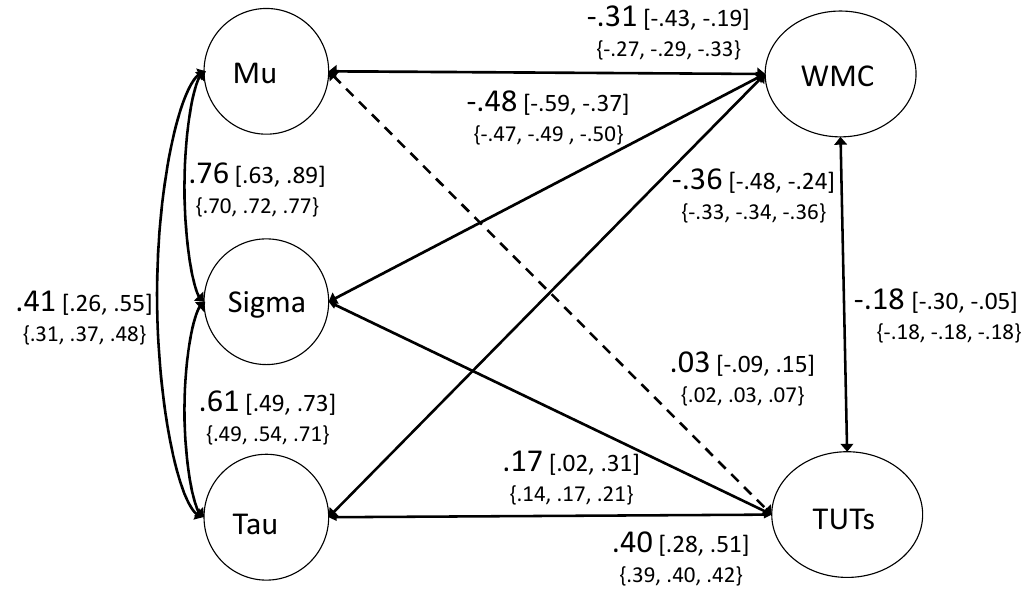
Figure 2. Confirmatory factor analysis of ex-Gaussian model. WMC = working memory capacity. TUTs = task-unrelated thoughts. Path estimates are presented in largest size font. The 95% confidence intervals are presented in brackets. Values in the braces below represent the lowest, median, and highest estimate from the mini multiverse analysis (see Section 3.3). For clarity, factor loadings are not presented here; see Supplemental Table S3 for factor loadings for all models included in the primary analyses.